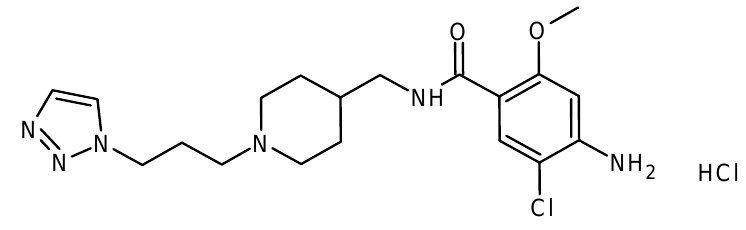
Figure 1. Chemical structure of DA-6886.